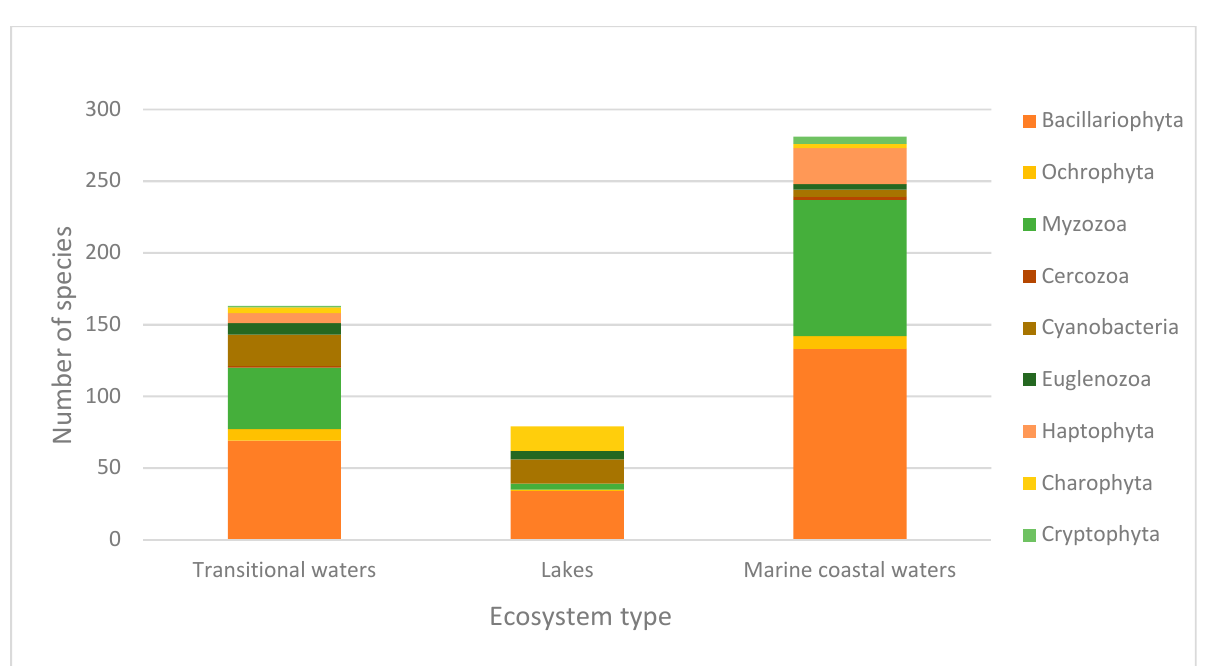
Figure 2. Number of species without a 16S barcode for the different phyla in transitional waters, lakes, and marine coastal waters.